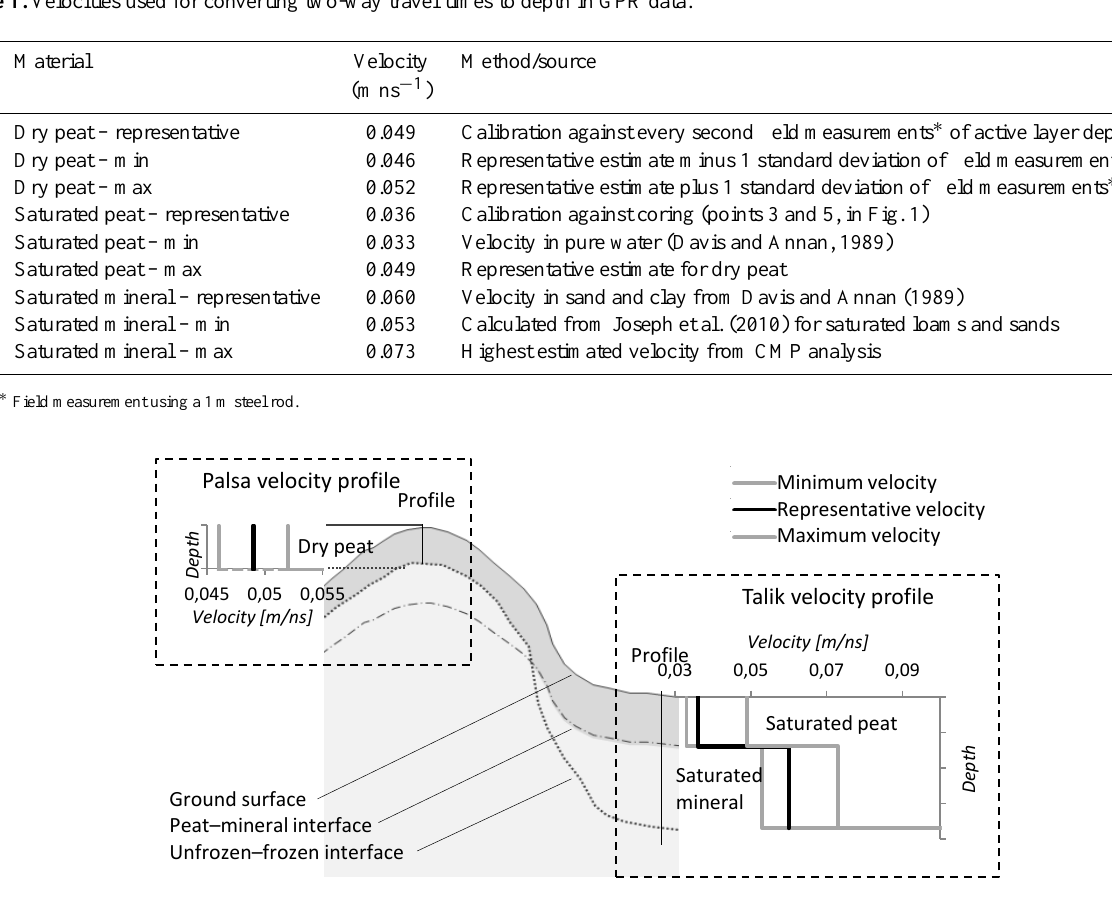
Table 1. Velocities used for converting two-way travel times to depth in GPR data.